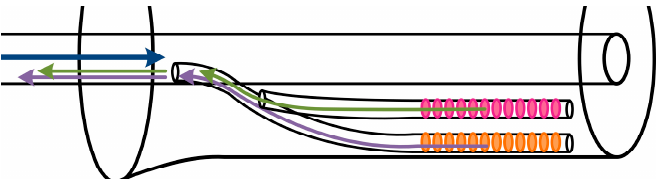
Figure 12. Glass fiber section with an integrated surface Bragg grating (orange colored) and a cladding Bragg grating (magenta colored) at the same axial position. This type of sensor represents a further development to that one shown in Figure 1, since not only a temperature compensation but also a strain and bending compensation can be realized by the cladding Bragg grating located in the middle radial position of the fiber cladding.